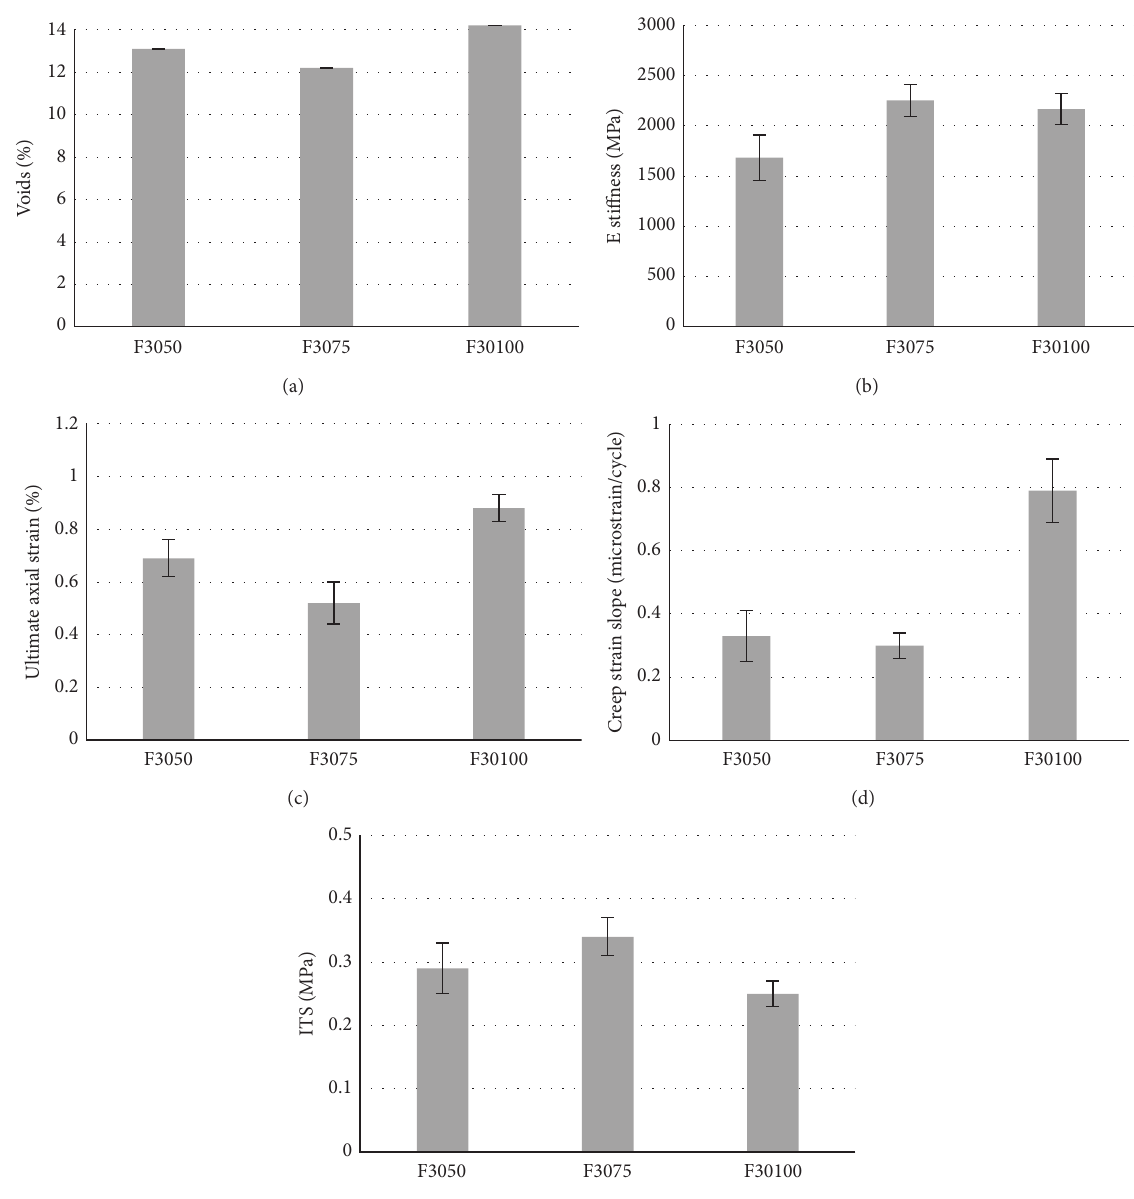
Figure 3: Effect of OMC content on mixtures: (a) voids, (b) stiffness, (c) UAS, (d) CSS, and (e) ITS. E: Stiffness Modulus.